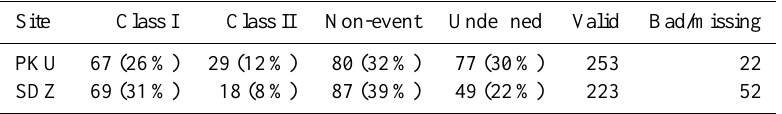
Table 1. Classification statistics of events at PKU and SDZ. N (%): N is the number of each class, and the value in parentheses indicates the percentage accounting for the days with valid data.